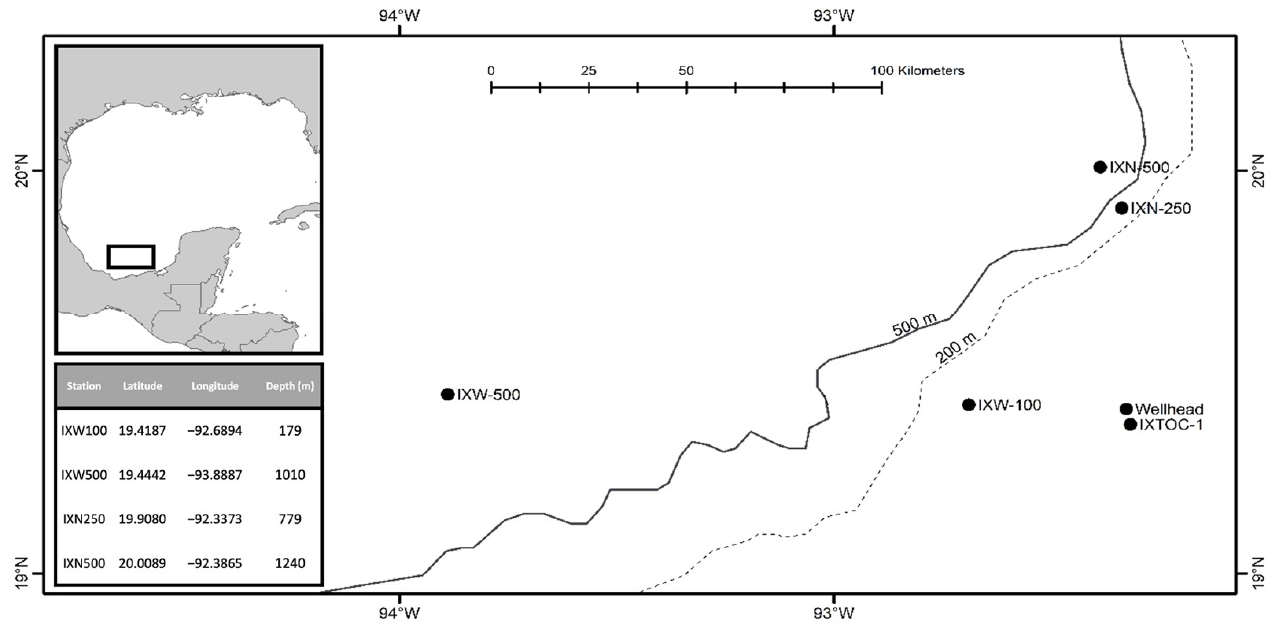
Figure 1. Map showing the location of the sample stations and depth.